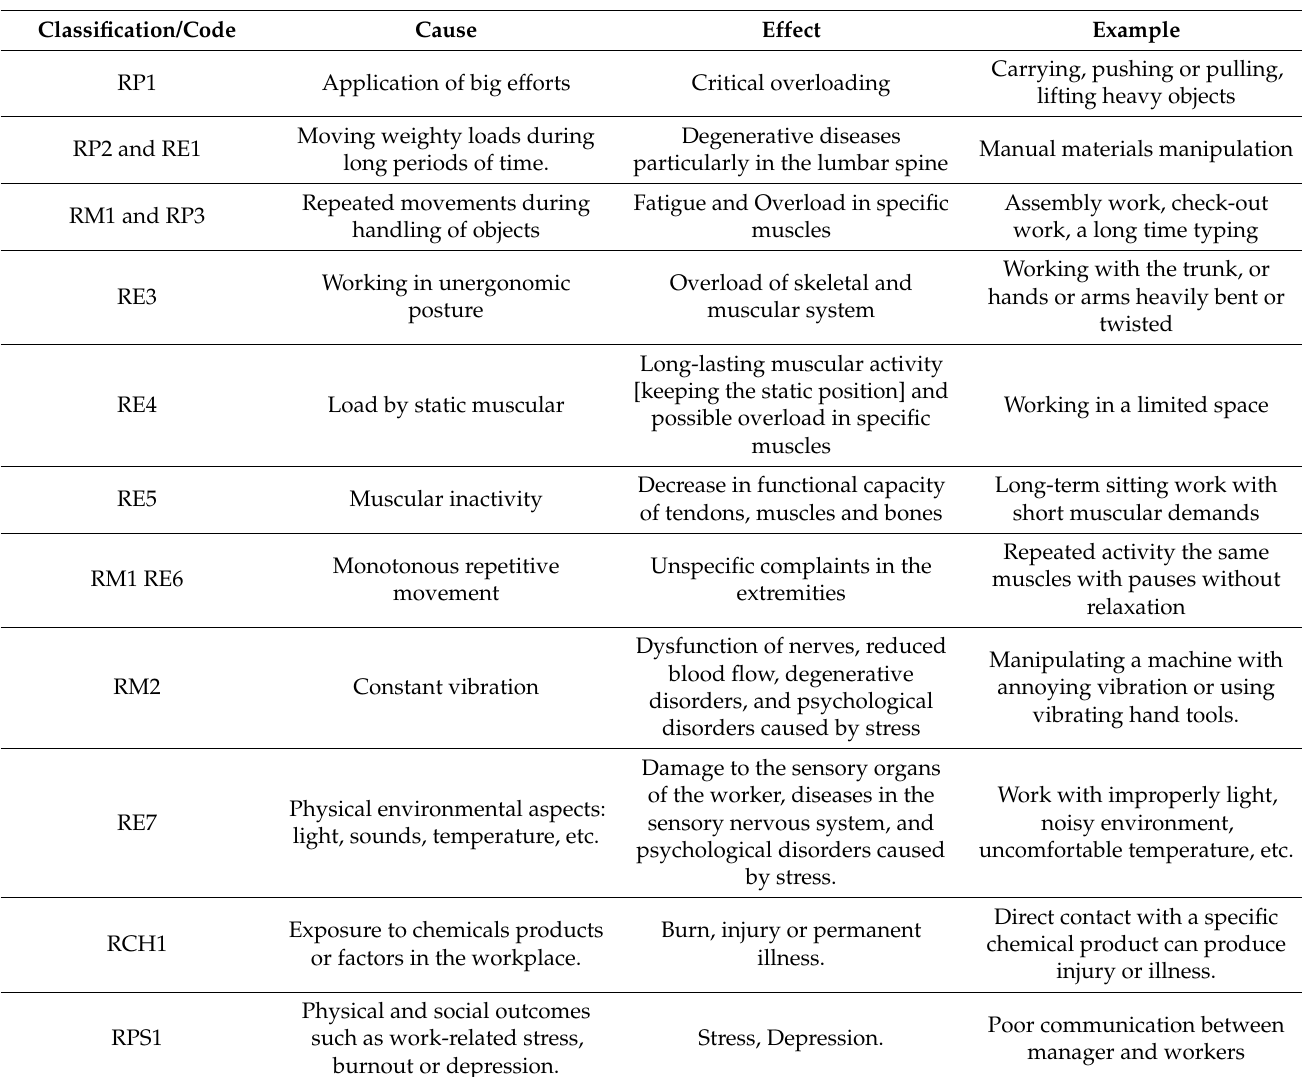
Table 2. Main factors contributing to musculoskeletal